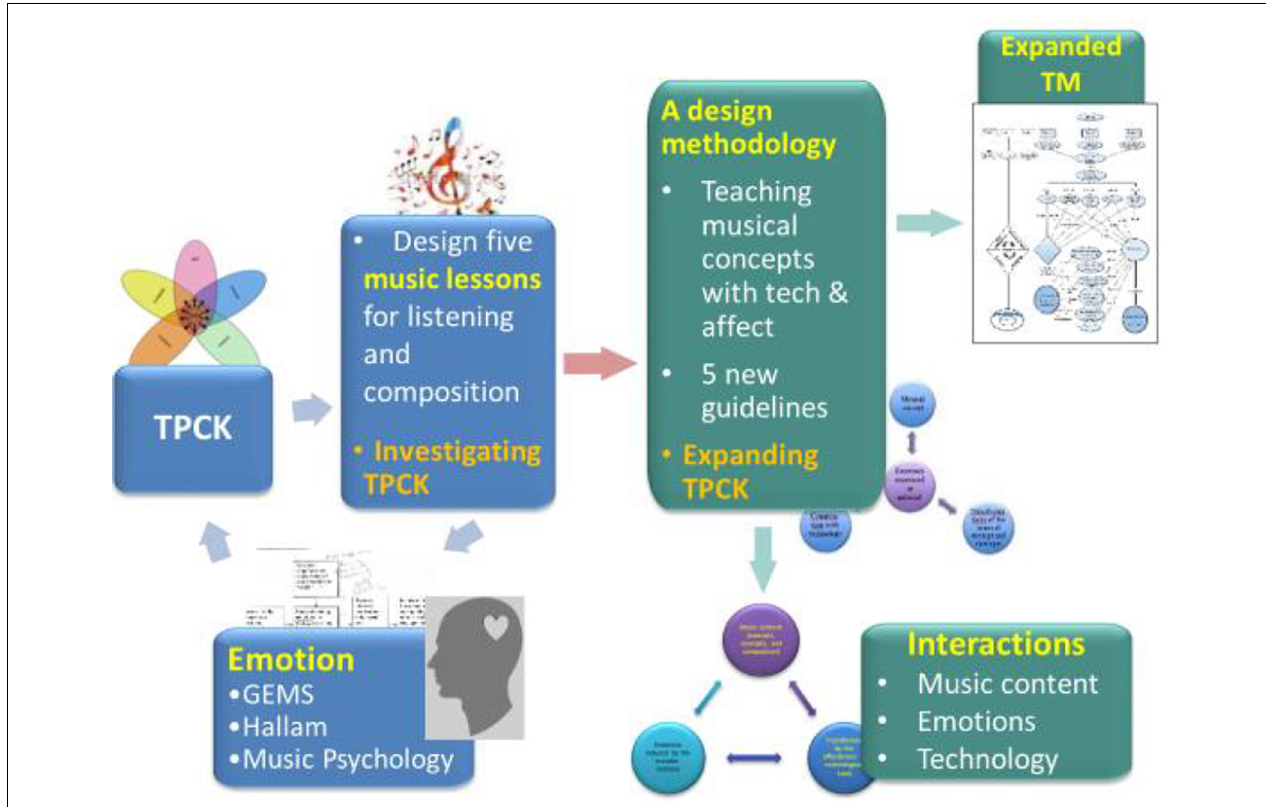
FIGURE 2 | Developing a design methodology through the process of investigating TPCK in music education.